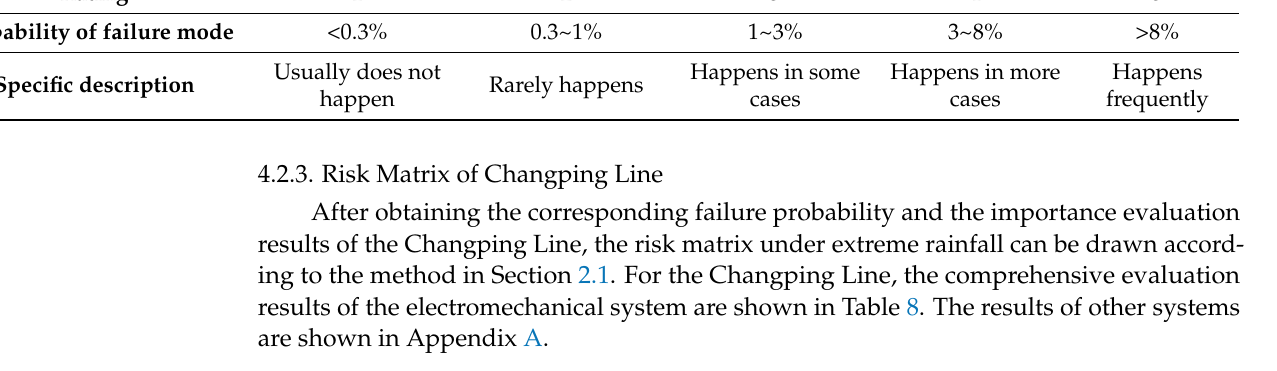
Table 8. The comprehensive results of the electromechanical system of the Changping